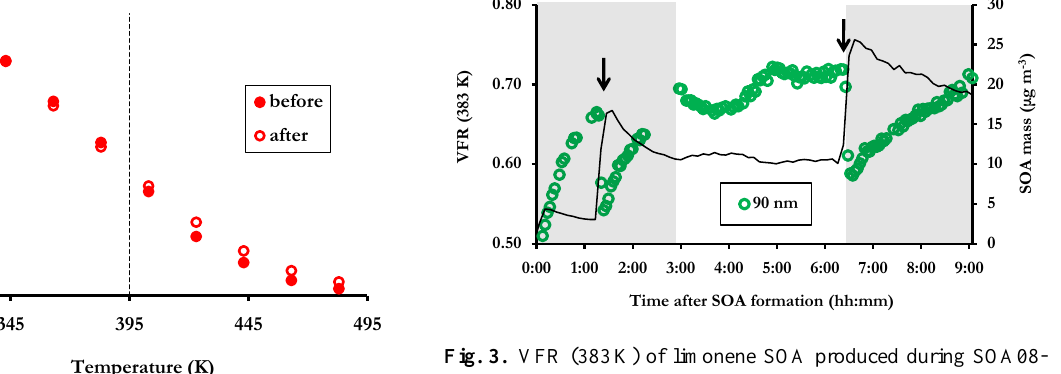
Fig. 3. VFR (383K) of limonene SOA produced during SOA08- 11 in the AIDA chamber and the change in measured SOA mass with time (black line). The white area indicates ageing with OH radicals (TME addition) and the black arrows show when limonene was